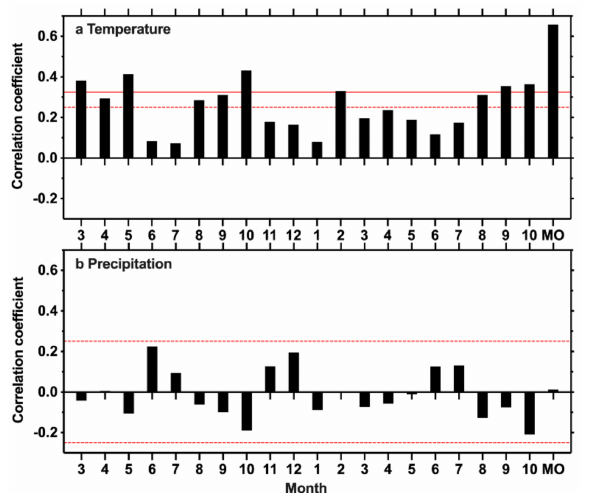
Figure 5. Correlation coefficients of the TRW chronology with ( a ) monthly mean temperature and ( b ) monthly total precipitation from the previous March to the current October during the common period 1958–2016. MO (previous March to previous October) represents the target months for reconstruction. Horizontal solid (dash) line denotes the 0.01 (0.05) significance level,